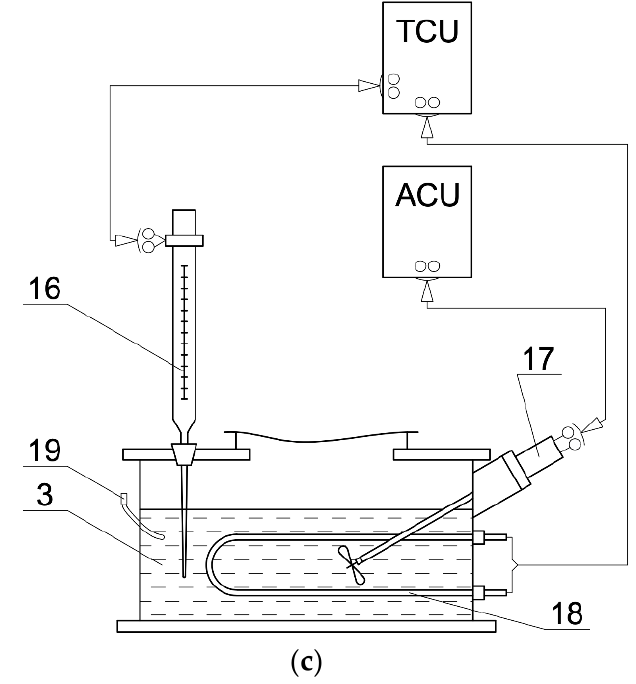
Figure 3. Device for recording the parameters of gas release and swelling of aerated concrete mixtures PGV-2A: ( a ) photo; ( b ) schematic diagram of PGV-2A; ( c ) connection diagram of the heating element and the stirrer of the reaction container.